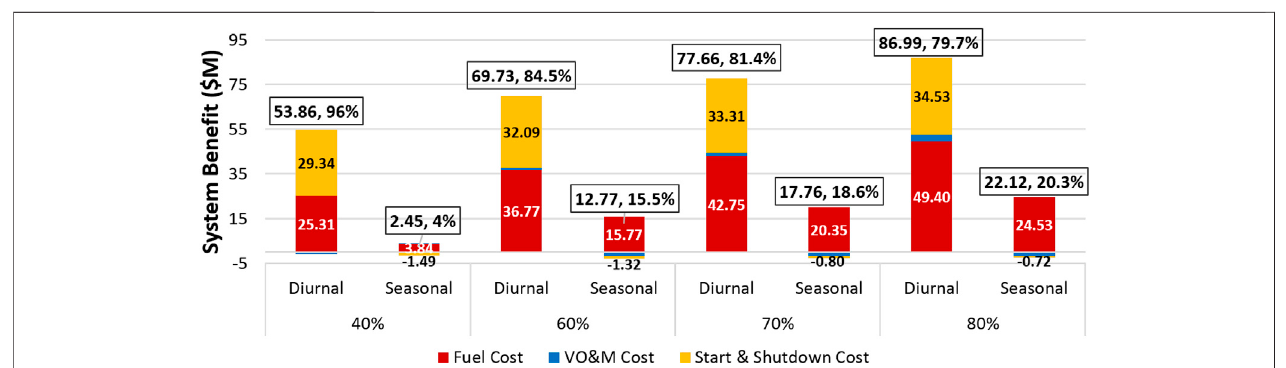
FIGURE 16 | The annual diurnal and seasonal bene fi ts comparison (value and percentage of the total system bene fi t) associated with the maximum bene fi t long- durationenergystoragescenariosin2050WIsystemincludingenergystorageswith (A) 40%round-trip ef fi ciencyand9-dayduration, (B) 60%round-trip ef fi ciencyand 24-day duration, (C) 70% round-trip ef fi ciency and 30-day duration, and (D) 80% round-trip ef fi ciency and 32-day duration.